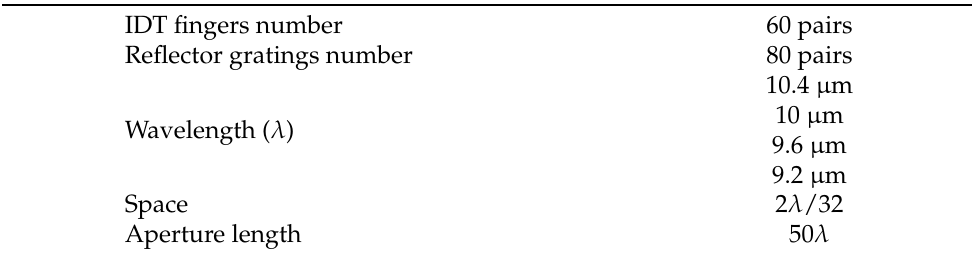
Table 1. Design parameters of QSAW resonators.